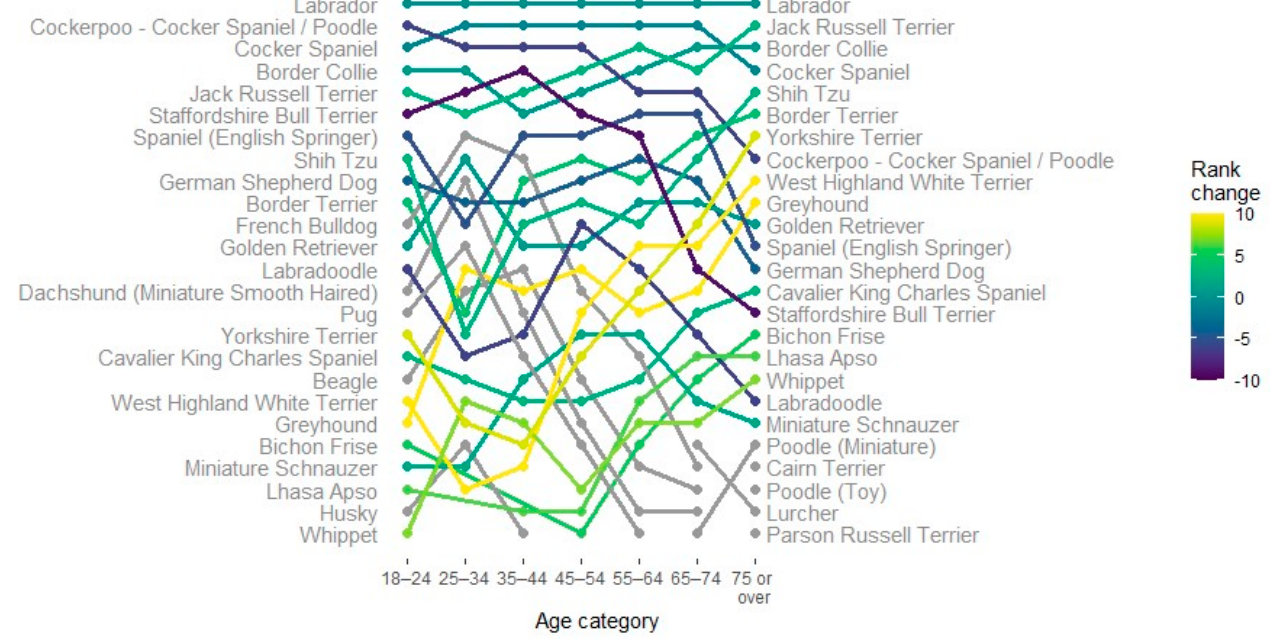
Figure 5. Graph showing differences in most popular breed ownership across owner age groups. Line colours represent breed rank change between the 18–24 and 75 or over age categories, with grey lines demonstrating the breed is not within the top 25 for one of these age